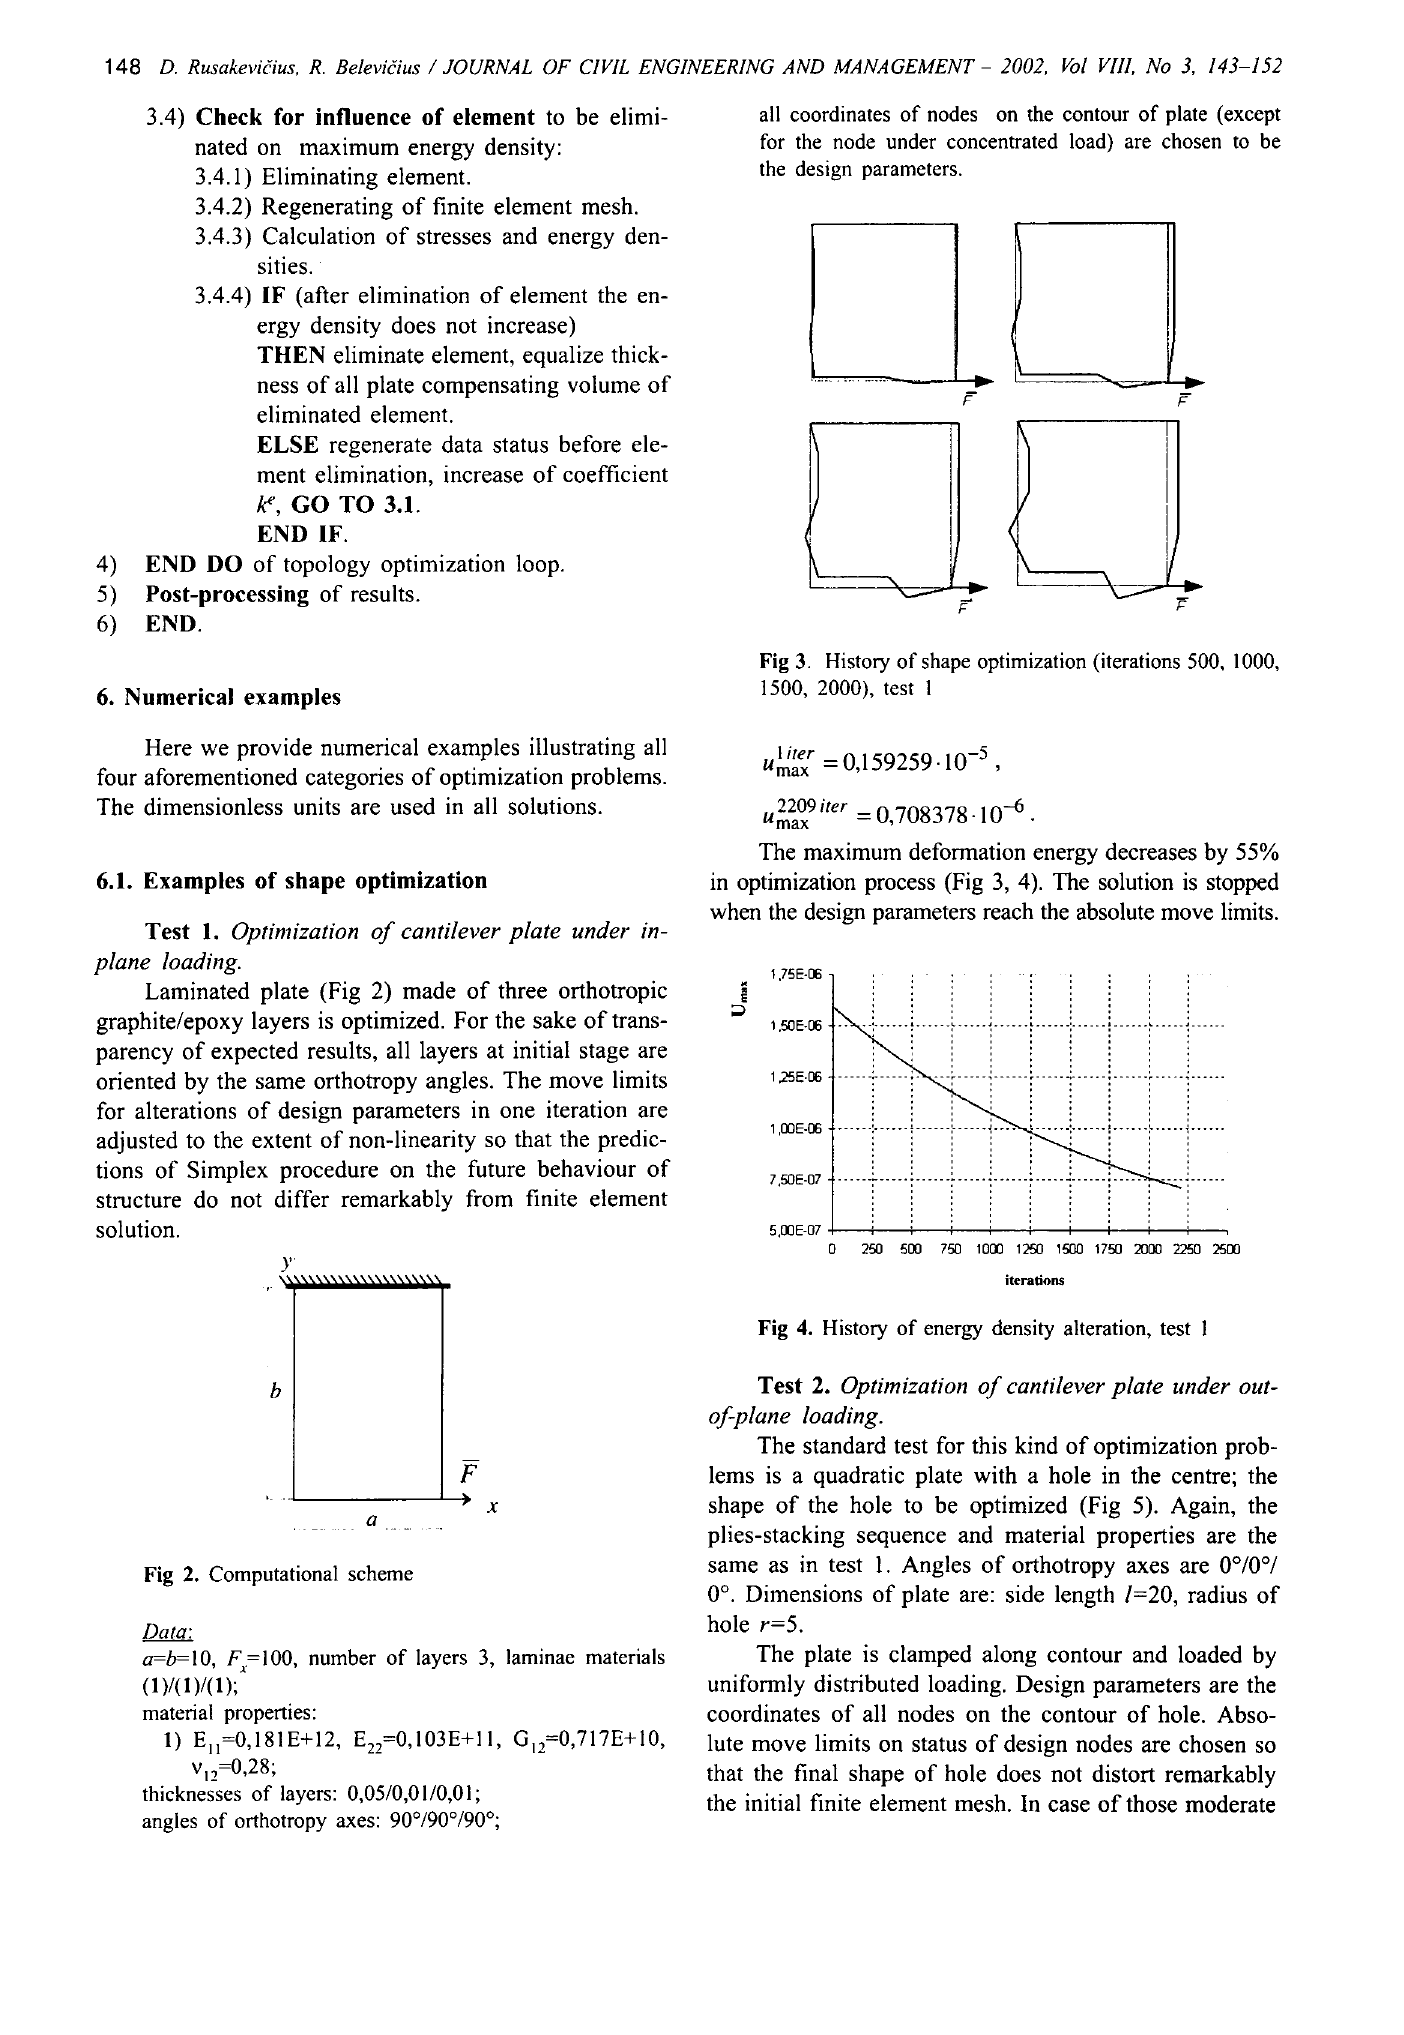
Fig 2. Computational scheme Data: